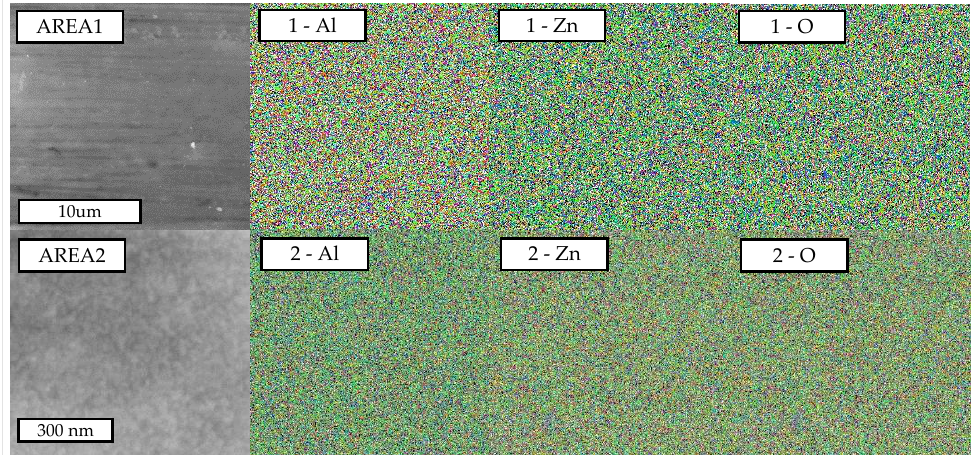
Figure 5. Mapping images observed by SEM-EDS for ZnAl 2 O 4 /Al sample. Area 1 shown on the top was 3000 times scale, and Area 2 (bottom) was 13,000 times, respectively.